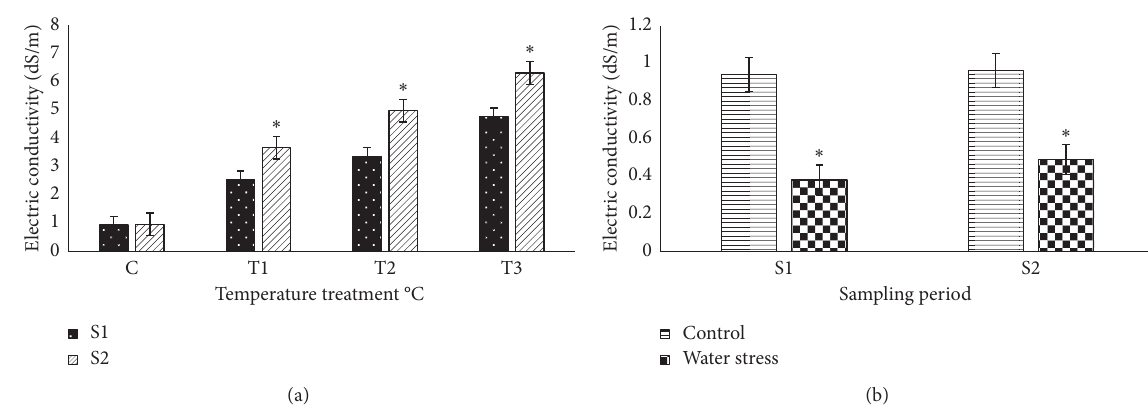
Figure 1: (a, b) Effect of different climate temperatures (C, 25 ° C; T electric conductivity (dS/m), measured in soil:water (1 :5) extracts after two sampling periods (S1, 14 days and S2, 21 days) in basil plants (mean ± SD, n � 5). Asterisks indicate significant differences between sampling periods of each treatment and differences between treatments for the same sampling periods according to the Tukey test ( α � 0.05).